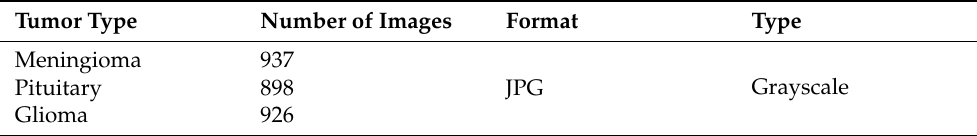
Figure 3. Samples of the brain tumor classification (MRI) dataset, upper row: Glioma tumor, middle row: meningioma tumor, and lower row: pituitary tumor. row: meningioma tumor, and lower row: pituitary tumor. Table 1. Brain tumor classification (MRI) dataset